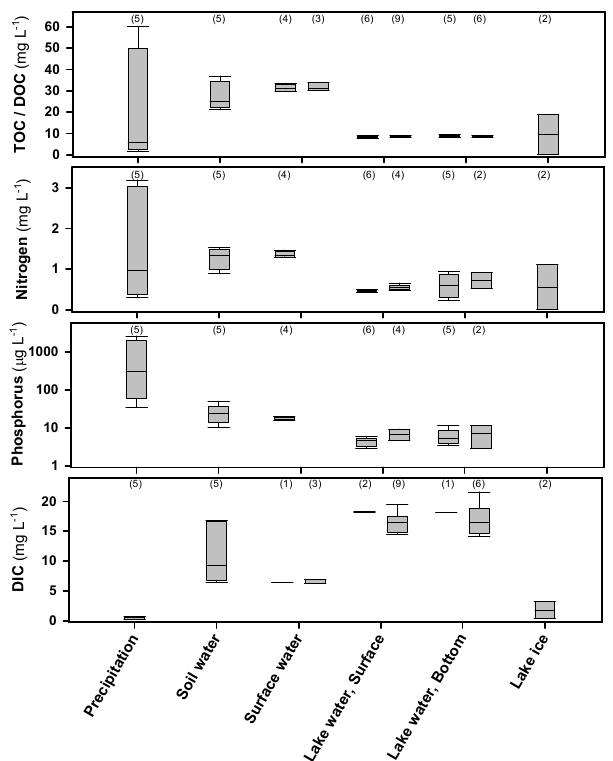
Figure 10. Box plot showing the concentrations of TOC/DOC, total nitrogen, total phosphorus and DIC in water samples from different catchment compartments. For surface and lake water, the box to the left represents unfiltered samples, while the box to the right repre- sents filtered samples. The boxes denote the median and the 25th and 75th percentiles, while the whiskers denote the 10th and 90th percentiles. The numbers within parenthesis represent the number of samples for each sample type.